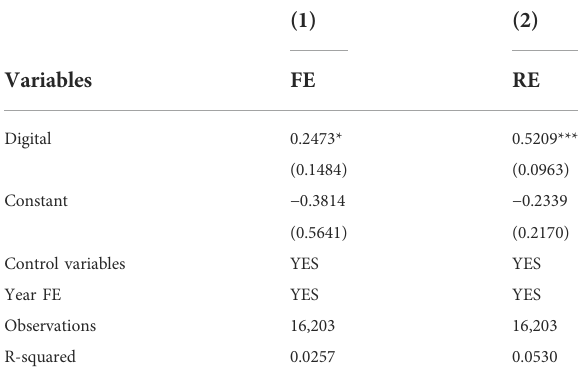
TABLE 10 Impact of digital economy development on ESG performance: Alternative